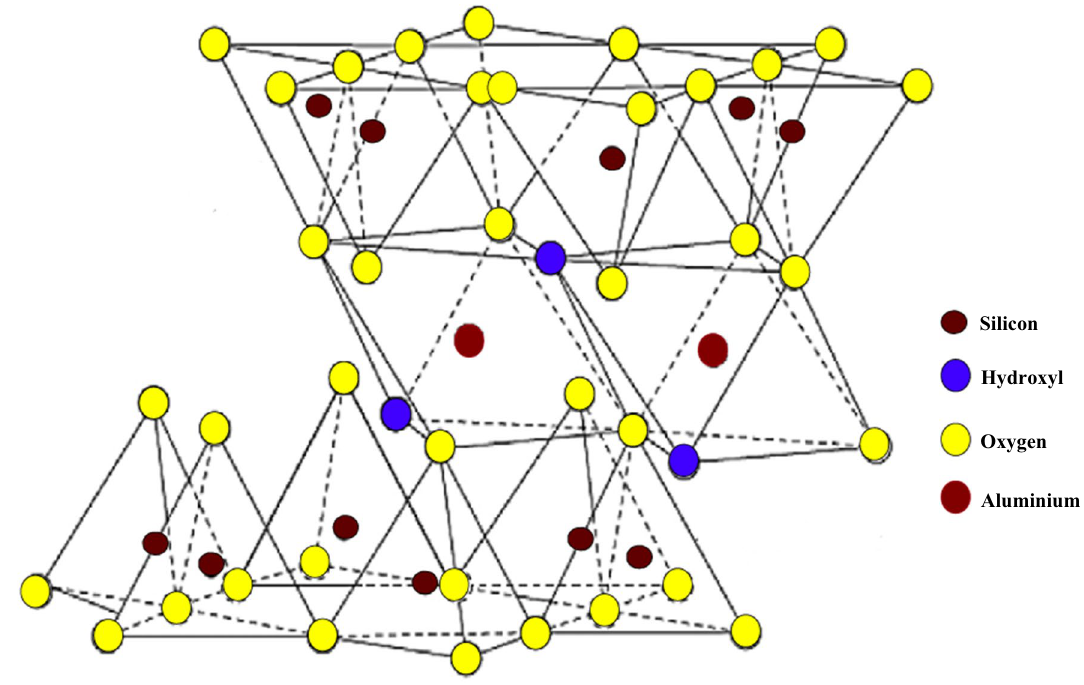
Fig. 17 Structure of